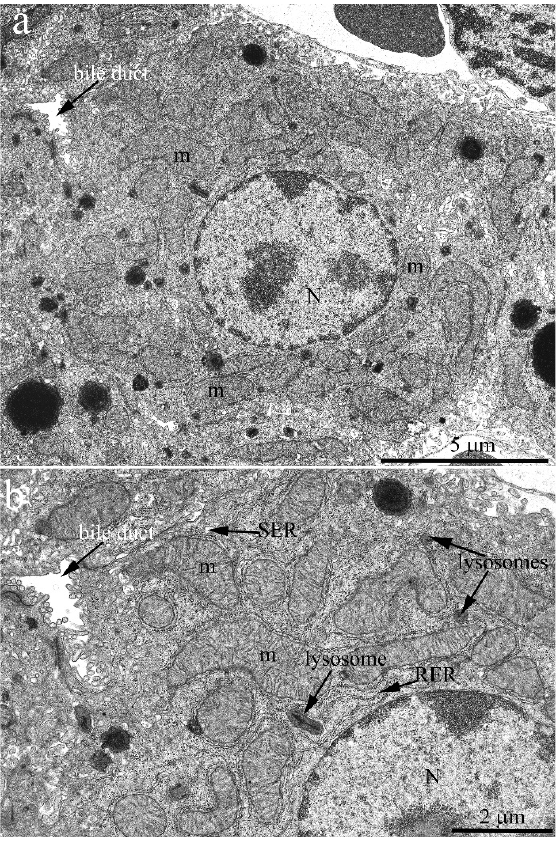
Figure 1. Hepatocyte ultrastructure in C57BL/6 mice aged 2 months. ( a ) Overview photograph. The hepatocyte has an irregular hexagonal shape with indistinct angles. A rounded nucleus (N) is located in the central part of the hepatocyte. The internal cell space is evenly filled with cell organelles. The arrow shows the bile duct; ( b ) the internal hepatocyte ultrastructure. In the hepatocyte cytoplasm, there are many mitochondria (m). Rough ER (RER) takes the form of stacks of membranes lying in parallel. Smooth ER (SER) membranes are minor and are located mainly close to the plasma membrane. Lysosomes are present in the